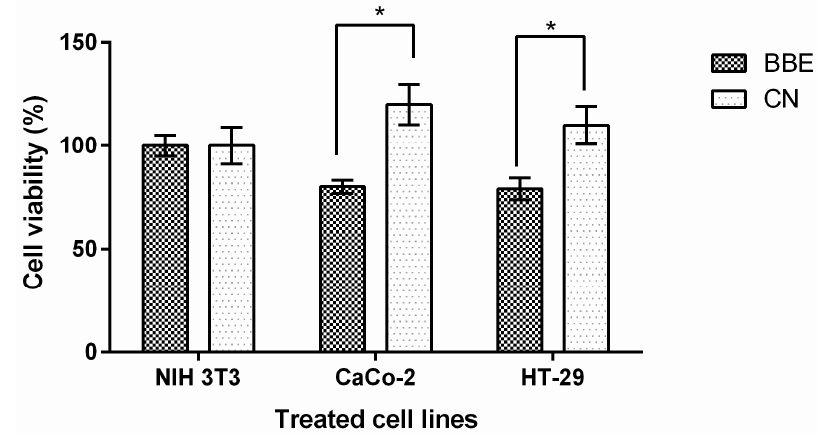
Figure 2. Growth inhibitory potency of whole wheat bread enriched with black bean seed coat extract (BBE) in comparison to whole wheat bread (CN) in cancer colon cell lines (HT-29, Caco-2) and standard fibroblast (NIH 3T3) used as control cell line. * Significant differences among treatments in each cell line after mean comparison with a Student’s t -test ( p > 0.05). Treatments were carried out with the obtained supernatant of in vitro gastric digestion of 100 mg of bread (CN or BBE) diluted 1:10.